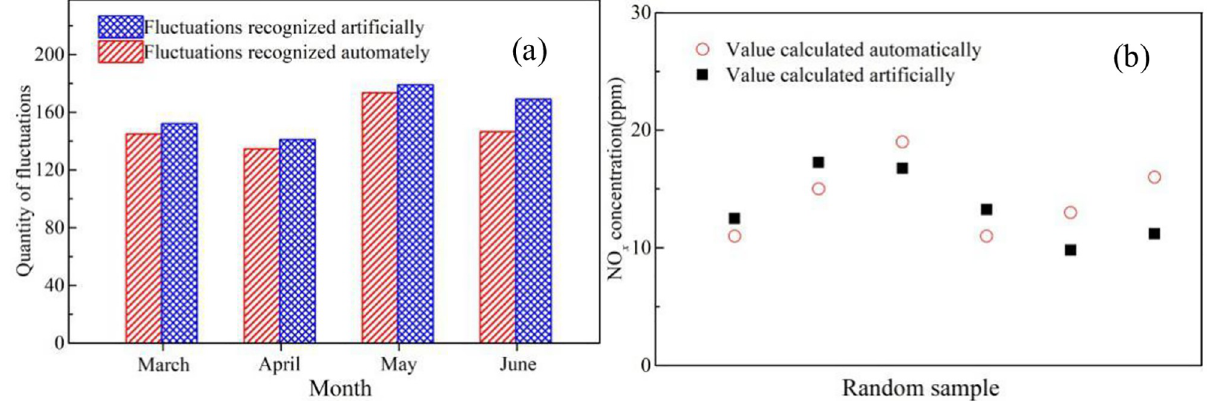
Fig 8. Comparison of (a) fluctuation quantities recognized automatically and artificially; (b)NO automatically.